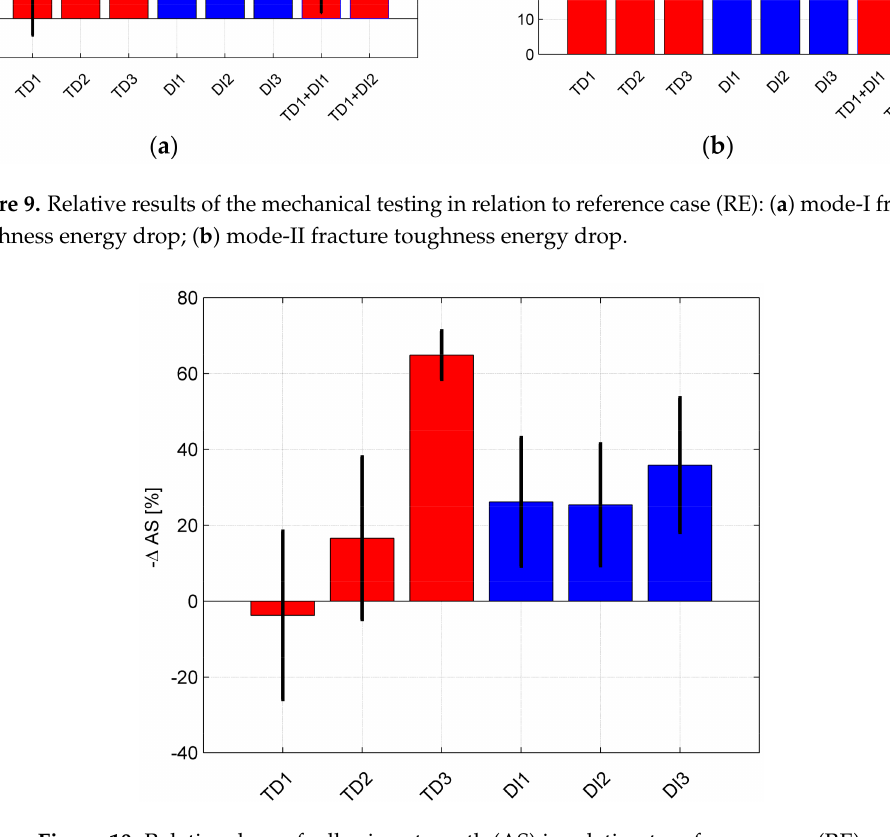
Figure 10. Relative drop of adhesion strength (AS) in relation to reference case